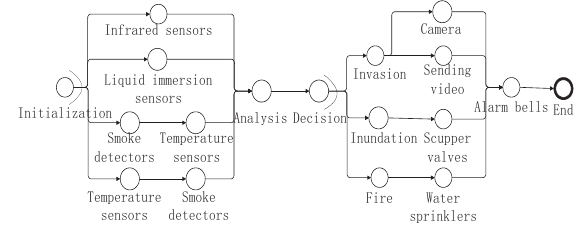
Fig.1. A composite service for the warehouse